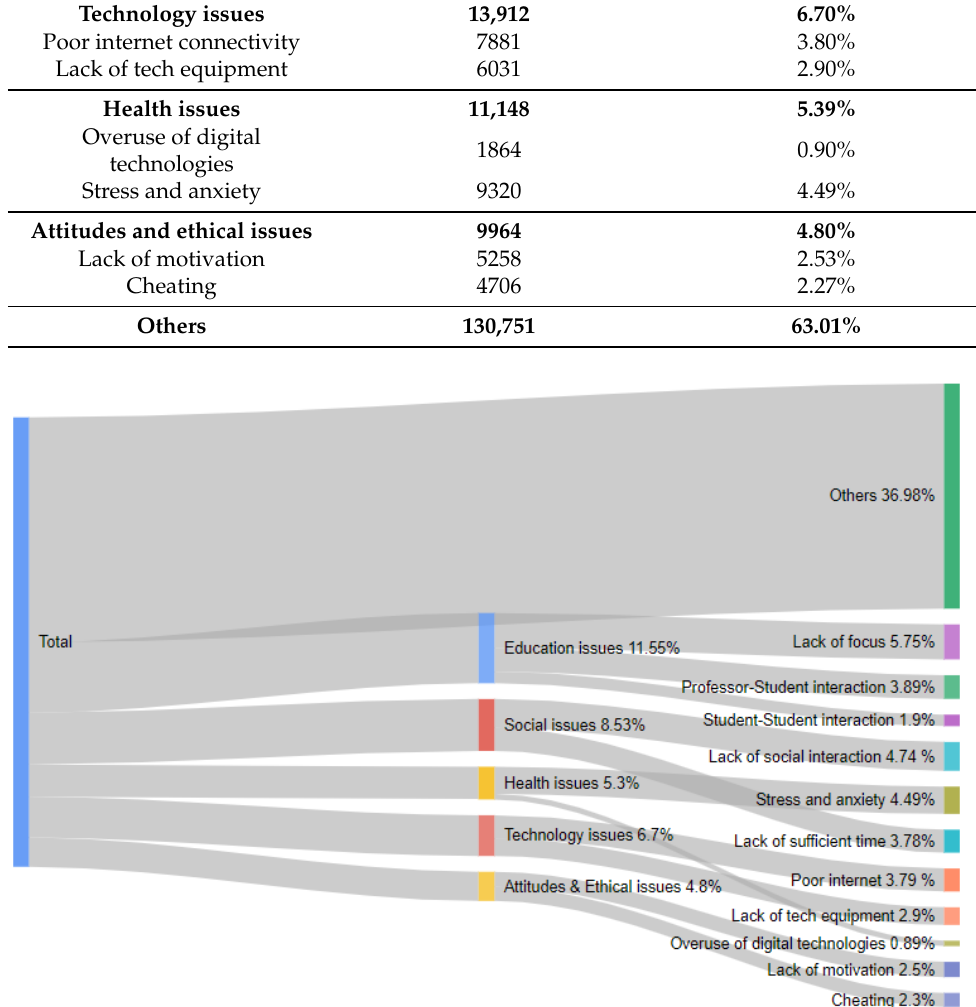
Figure 5. The distribution of general and sub